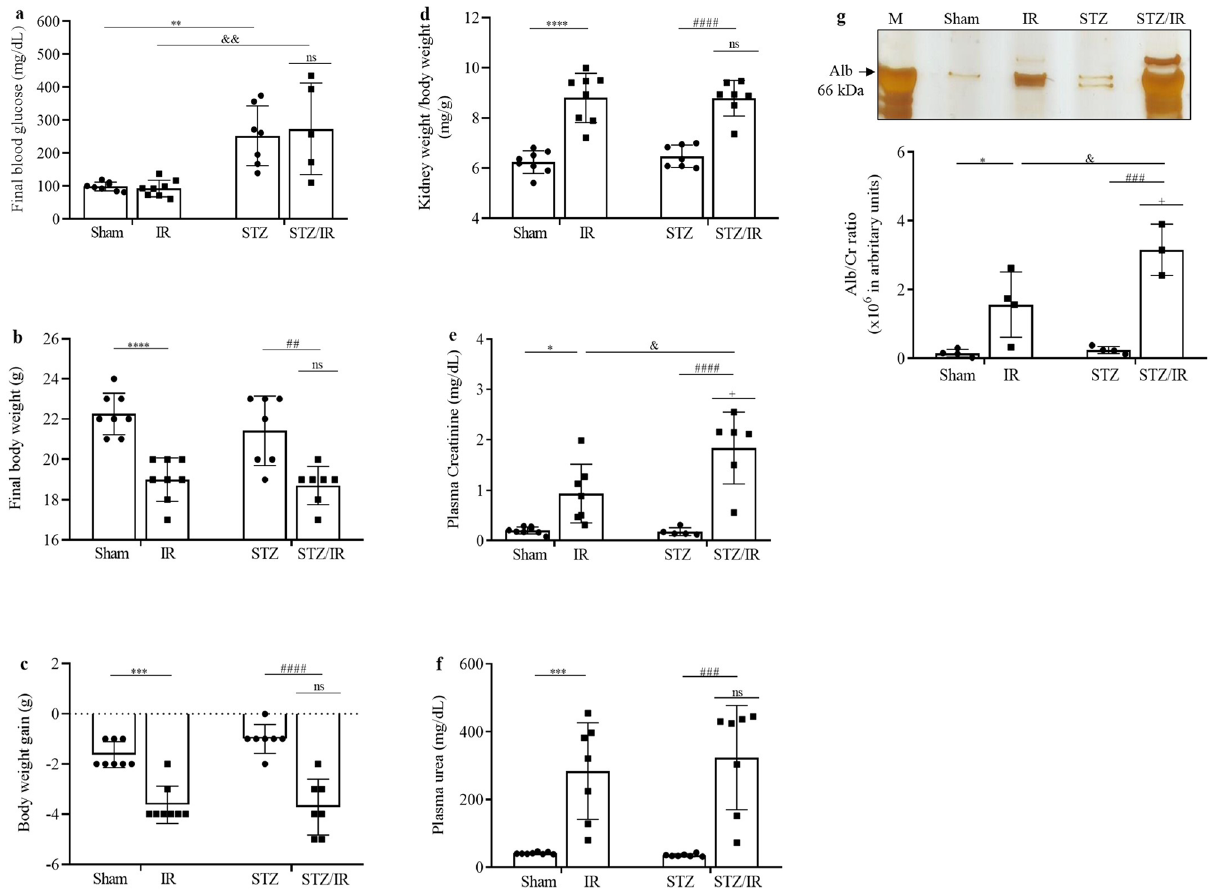
Figure 1. Effect of renal ischemia/reperfusion in vehicle- and STZ-treated mice on final blood glucose ( a ), final body weight ( b ), body weight gain ( c ), kidney weight/body weight ( d ), and plasma levels of creatinine ( e ), urea ( f ) and albuminuria ( g ). + p < 0.05 for the interaction between diabetes and renal IR (STZ/IR), as indicated by two-way ANOVA (Supplementary Table S1). The Bonferroni post hoc test was also performed: *p < 0.05, **p < 0.01, ***p < 0.001, ****p < 0.0001 vs sham group; ## p < 0.01, ### p < 0.001, #### p < 0.0001 vs STZ group; & p < 0.05, && p < 0.01 vs IR group. The values are the mean ± S.D. (n = 3–8). The samples were obtained from the same experiment. Sham sham-operated, IR ischemia/reperfusion, STZ streptozotocin, STZ/IR streptozotocin/ ischemia/reperfusion, Alb albumin, M marker, Cr creatinine, ns